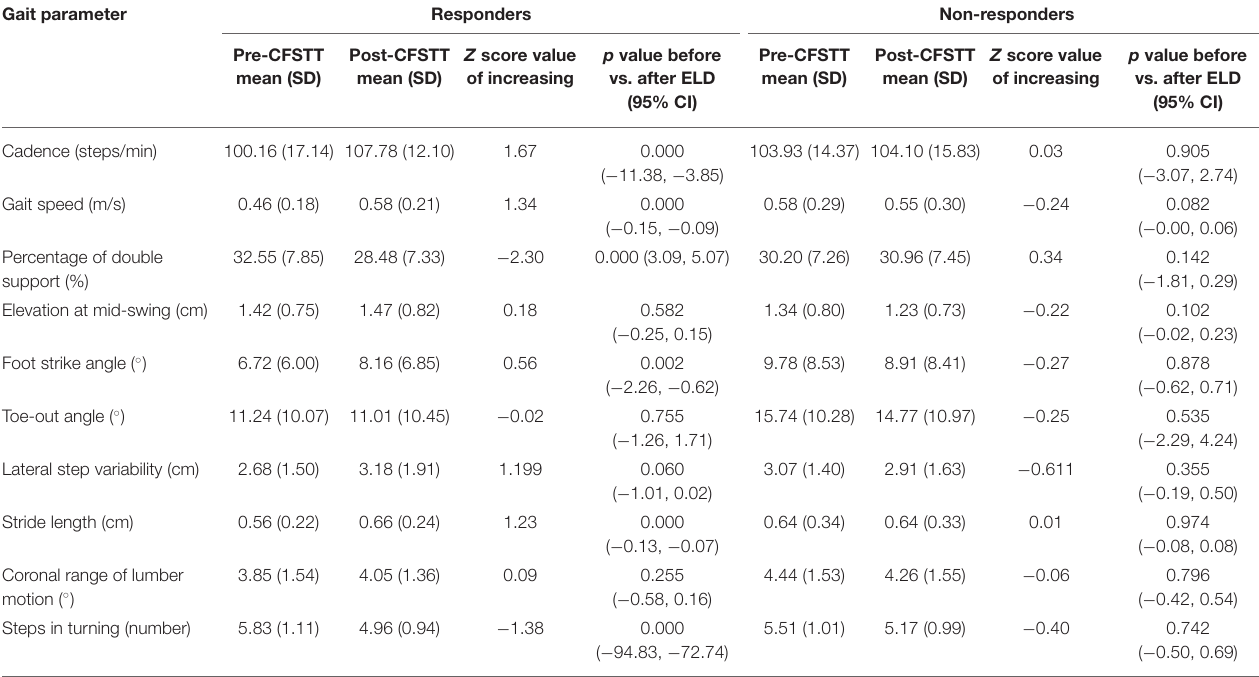
TABLE 3 | Mean values of gait parameters before and after ELD and Z -score values of improvement after ELD.